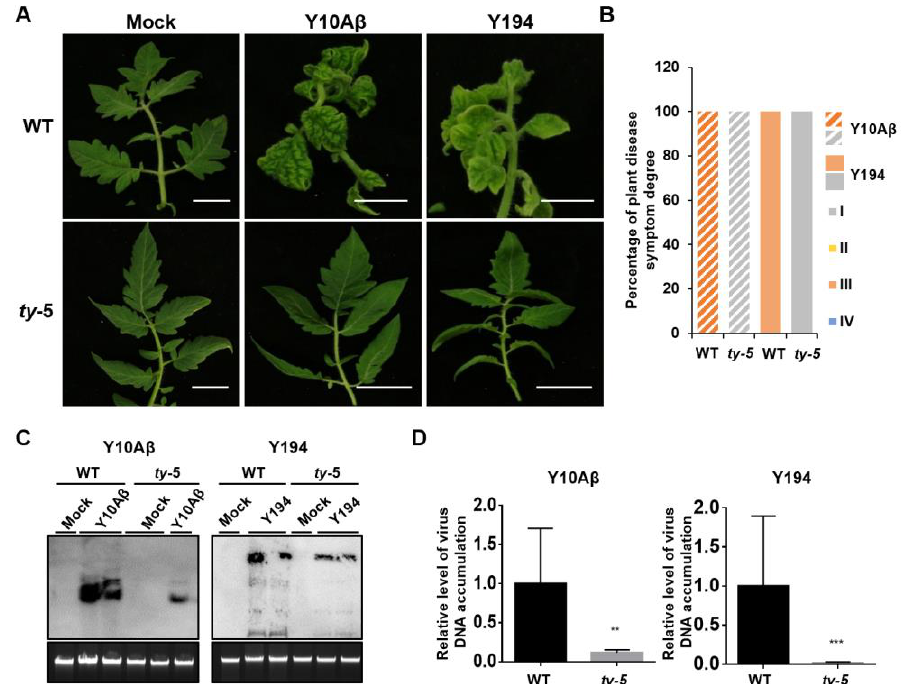
Figure 2. The ty -5 gene confers resistance to two representative begomoviruses from China. ( A ) Viral symptoms in the tomato ty-5 line with a Pelota V16G mutation and the wild-type (WT) line, agroinfected with either the pBinPLUS empty vector (mock), an infectious clone of tomato yellow leaf curl China virus (TYLCCNV)/tomato yellow leaf curl China betasatellite (TYLCCNB) (Y10A β ), or tomato leaf curl Yunnan virus (TbLCYnV, Y194). The inoculated plants were photographed at 7 weeks post-inoculation (wpi). ( B ) The percentage and degree of plant disease symptoms in WT and ty-5 plants infected by TYLCCNV/TYLCCNB (Y10A β ) or TbLCYnV (Y194) at 7 wpi. In total, 15 plants from each line were used for the assays. Disease symptoms were classified from grade I (no symptoms) to grade IV (very severe symptoms). ( C ) Southern blotting analysis of viral DNA accumulation in WT and ty-5 lines infected with TYLCCNV/TYLCCNB (Y10A β ) or TbLCYnV (Y194) at 7 wpi. DNA fragments of TYLCCNV or TbLCYnV capsid protein were used as probes for detection of genomic DNA from TYLCCNV and TbLCYnV, respectively. ( D ) qPCR analysis of viral DNA accumulation in WT and ty-5 lines infected with TYLCCNV/TYLCCNB (Y10A β ) and TbLCYnV (Y194) at 7 wpi. Specific primers for TYLCCNV or TbLCYnV capsid protein were used to quantify the accumulation of viral DNA; 25S rRNA was used as the internal control. Asterisks denote statistically significant differences evaluated with Student's t test, ** p < 0.01, *** p < 0.001.